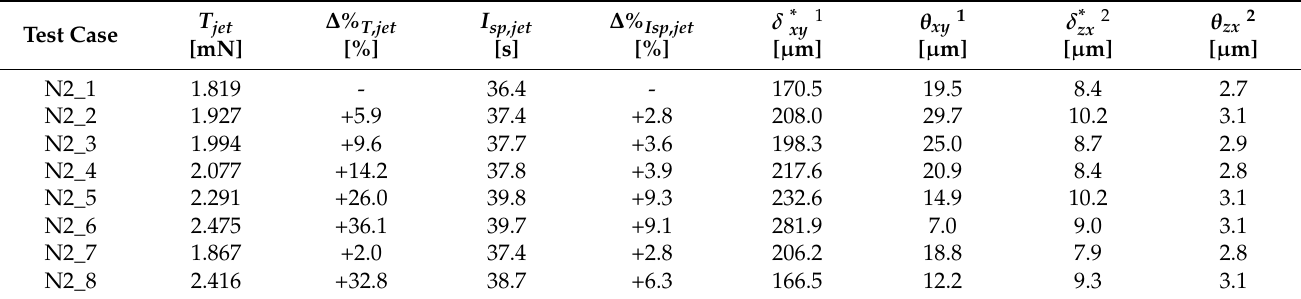
Table 10. Analysis of the flow expansion into the micro-nozzle: nitrogen gaseous